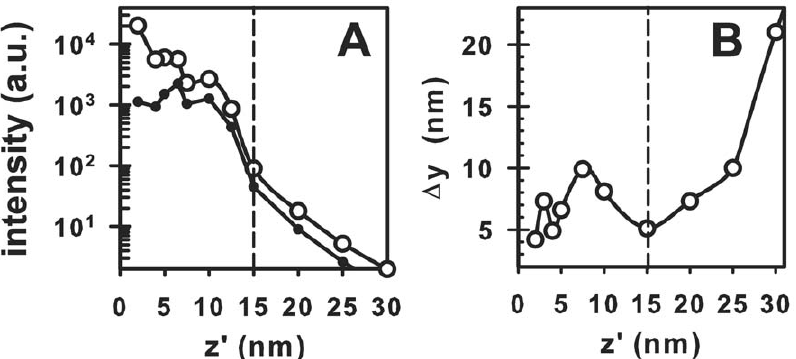
Figure 6. Imaging a GFP-like source (dipole axis in ^ zz -direction) with an optimized superlens. (a) Peak image intensity as a function of source-superlens distance z ’ , including ( open circles ) and neglecting ( solid circles ) modifications to the decay-rate from non-radiative coupling to the superlens. (b) Estimated resolution for the same setup. The dashed vertical line in both plots represents the distance at which Eqn. 3 holds. All superlens parameters are the same as for Fig. 3a & b.